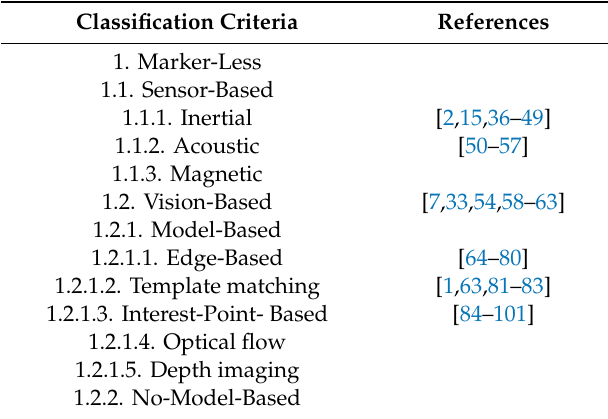
Table 1. Distribution of papers in di ff erent